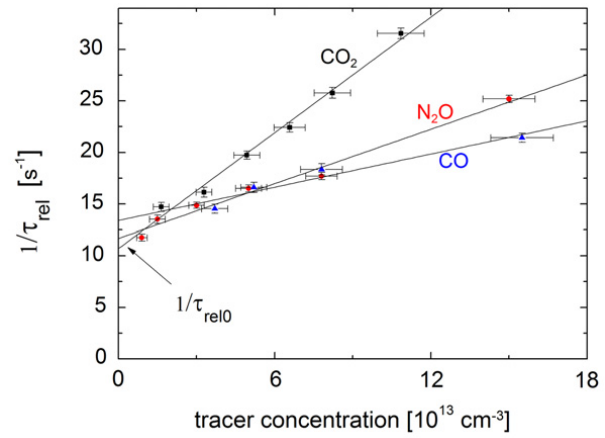
Figure 10. Characteristic relaxation frequencies (1/ τ rel ) as a function of the concentration of IR tracers left after the discharge pulse. The solid lines show a linear fit of the experimental data [52], © IOP Publishing. Reproduced with permission. All rights reserved.